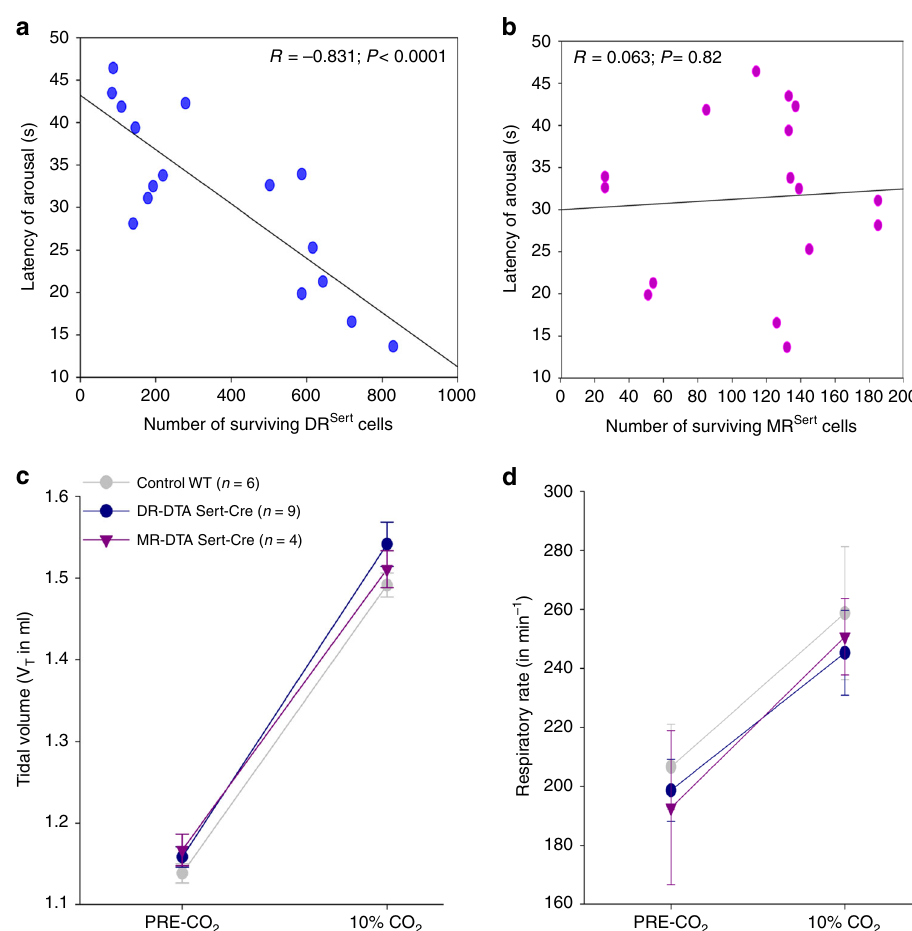
Fig. 3 Deletion of DR but not MR serotonin neurons prevents hypercapnic arousal. Correlations of DR Sert and MR Sert neuronal loss to the CO 2 arousal ( a – b ), and effects on the respiration ( c – d ). Panels a and b are the regression graphs showing the correlation of the loss of DR Sert and MR Sert neurons, respectively, to the latency of arousal to CO 2 across all three treatment groups, WT, DR/DTA, and MR/DTA. Note the close correlation of the loss of DR Sert neurons with mean latency to arousal, even in experiments where the deletion was aimed at the MR ( P < 0.001, Pearson ’ s correlation coef fi cient), and the lack of correlation of loss of MR Sert neurons with latency to CO 2 arousal ( P = 0.82). The tidal volume ( c ) and the respiratory rate ( d ) both before and after exposure (mean ± SEM) to CO 2 did not differ among the treatment groups, indicating that the DR Sert neurons appear to have little role in modulating the ventilatory response to CO 2 . Data in c and d are presented as mean values ±